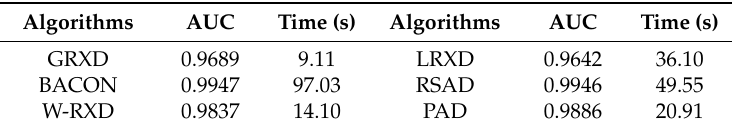
Table 2. AUCs and processing times (s) produced by the different detectors for the WTC data. See also Figures 3 and